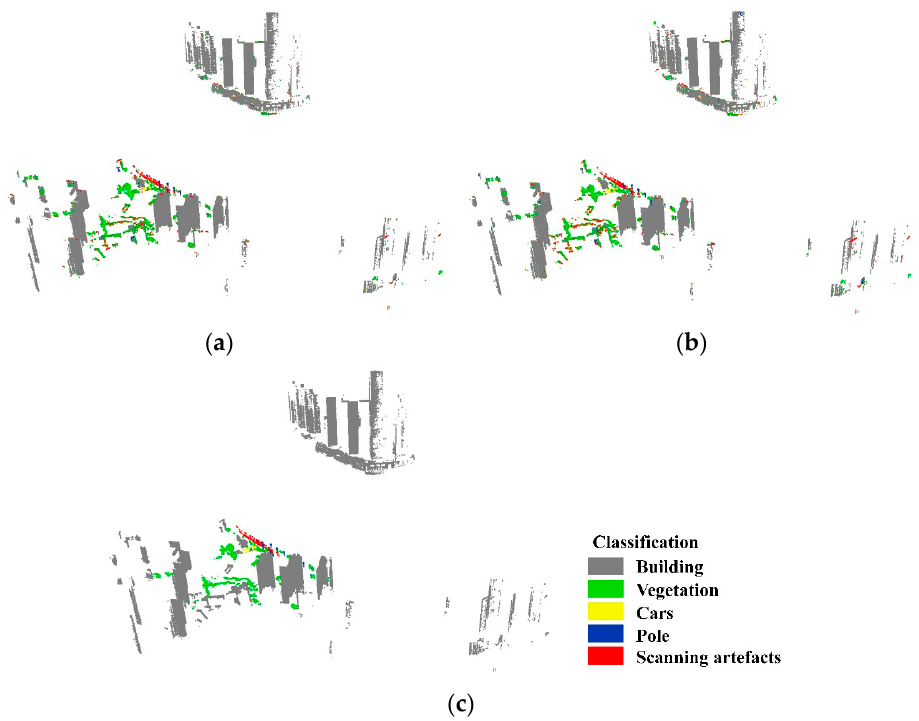
Figure 14. Classification results obtained by traditional projection density and relative projection density. ( a ) The traditional projection density, ( b ) the relative projection density, ( c ) the ground truth.